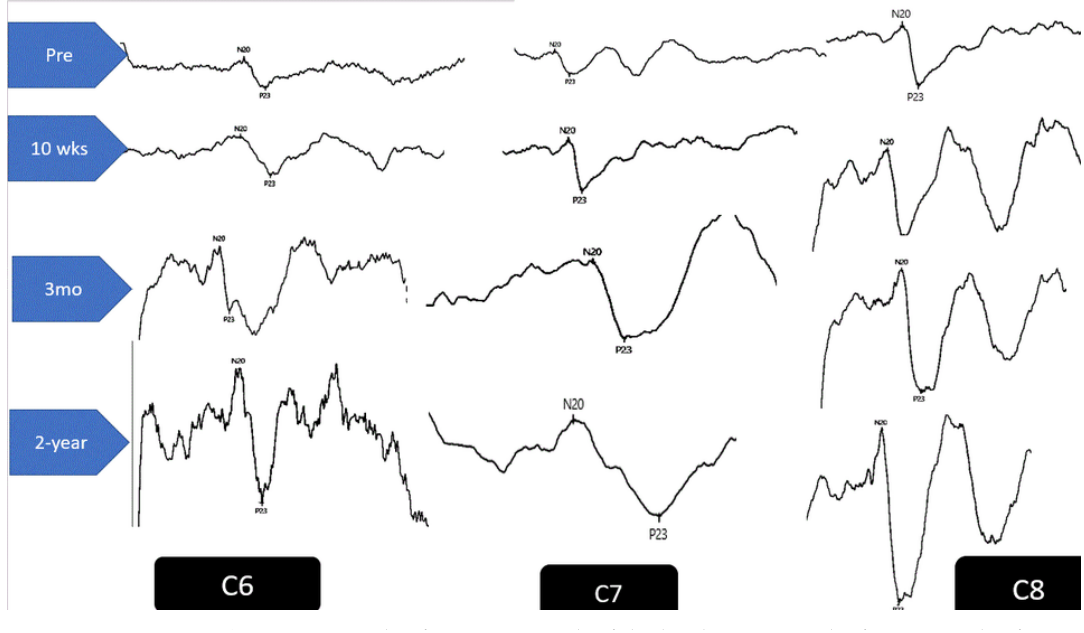
Figure 8. Example of DSSEPs at each of the levels C6–C8 at the four intervals of measurement for the study group (2-way traction).